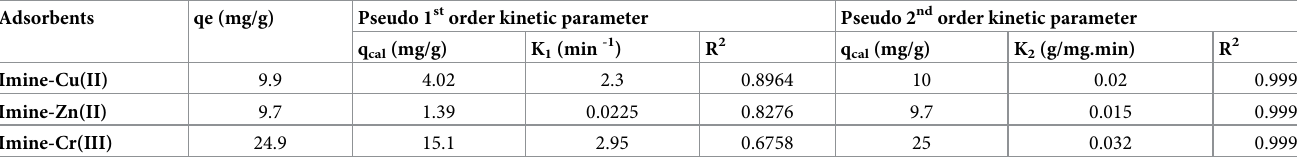
Table 3. Kinetic study parameters of Cu(II), Cr(III) and Zn(II) ion adsorption of imine. Adsorbents qe (mg/g)